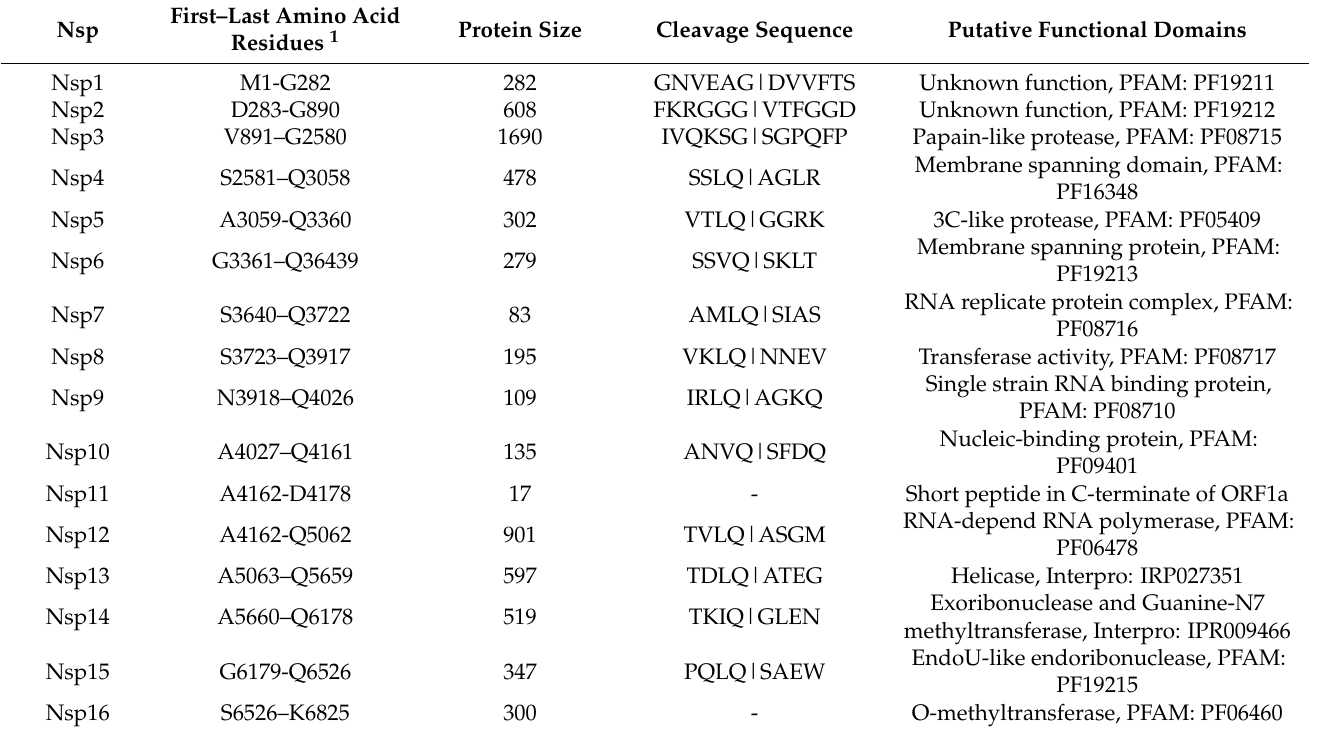
Table 3. Putative nonstructural proteins and the cleavage sites of polyproteins 1a and 1ab of the HCQD-2020